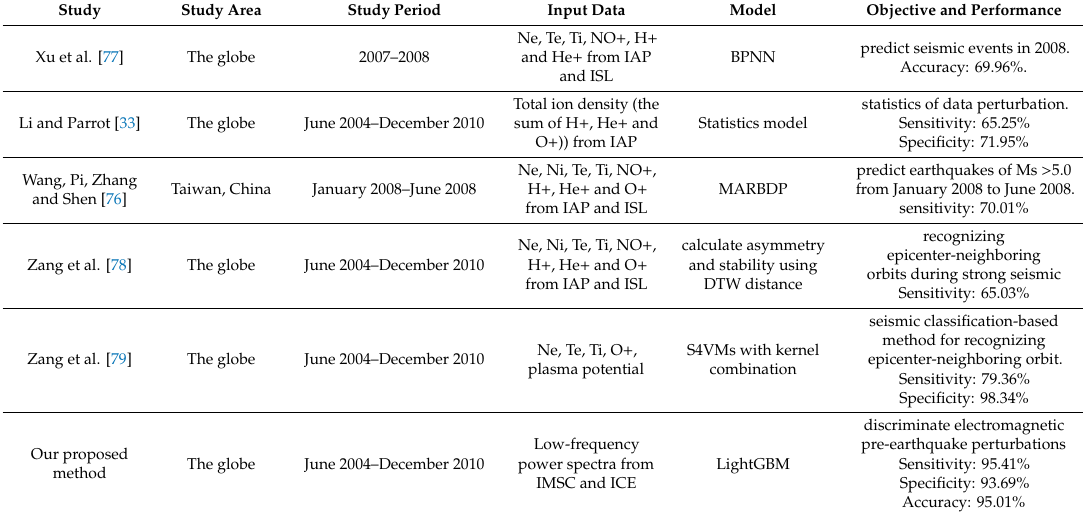
Table 7. Previous studies using machine learning for pre-earthquake perturbations analysis from the DEMETER data. BPNN: back-propagation neural network. MARBDP: mining association rule based on dynamic pruning. DTW: dynamic time warping. S4VMs: safe semi-supervised support vector machines. IAP: plasma analyzer instrument. ISL: Langmuir probes